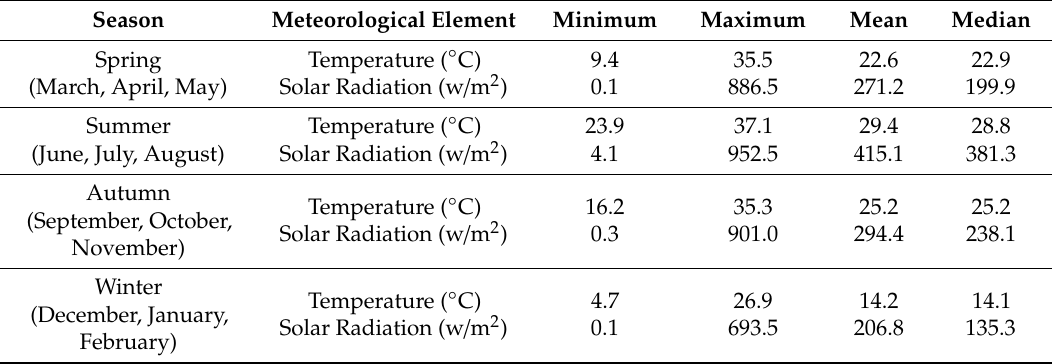
Figure 1. Observation site at GPACS (Guangzhou Panyu Atmospheric Composition Station) and its surrounding area from Google Maps. Table 1. The temperature and solar radiation (7:00–18:00 Local Time (LT)) in each season from June 2011 to May 2012 at